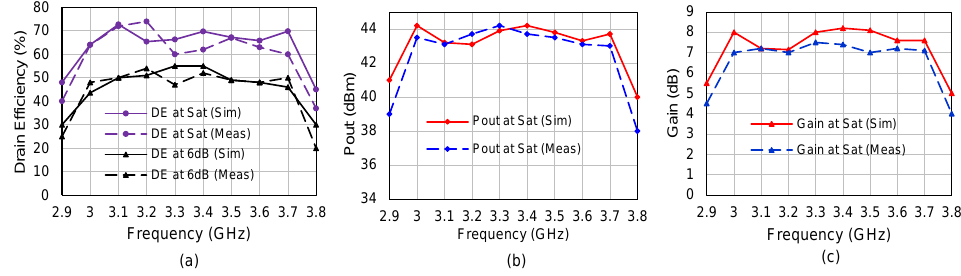
Figure 11. Measured (dashed) and simulated (solid) CW performance of the proposed DPA versus frequency at saturation and at 6 dB OBO: ( a ) drain efficiency, ( b ) output power, and ( c ) gain.